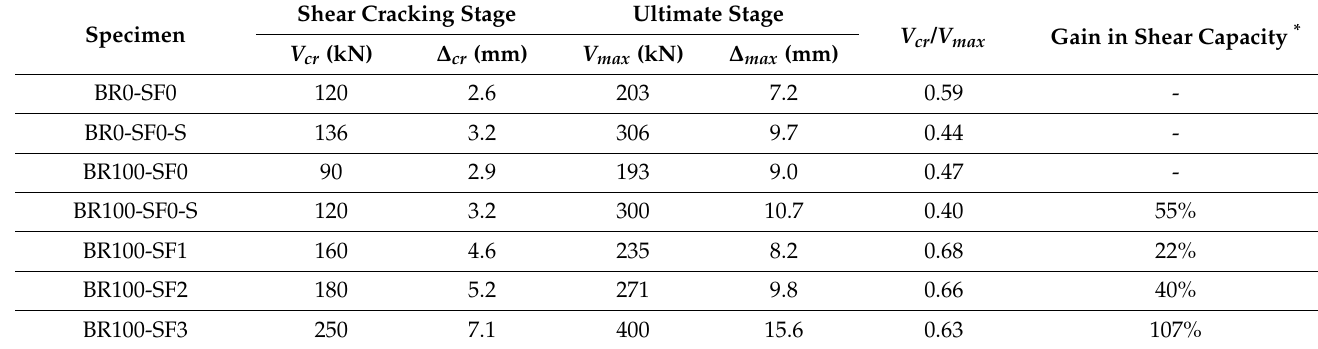
* With respect to the shear capacity of